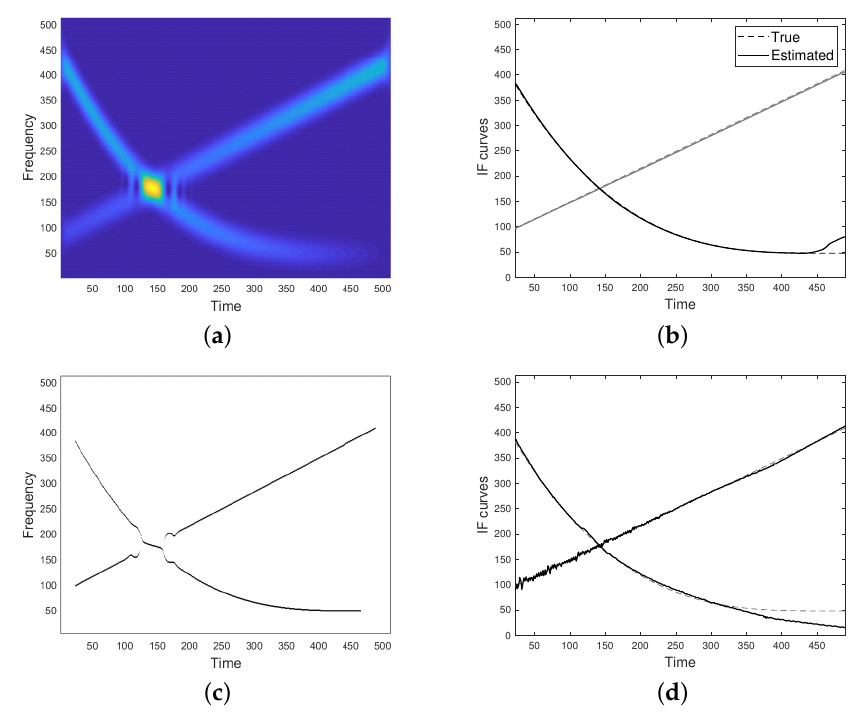
Figure 8. ( a ) Spectrogram of the AM-FM two-component signal as in Equation (27). ( b ) IF curves provided by the proposed method. ( c ) IF curves estimated from spectrogram maxima. ( d ) IF curves estimated by applying the Radon Spectrogram-based method in